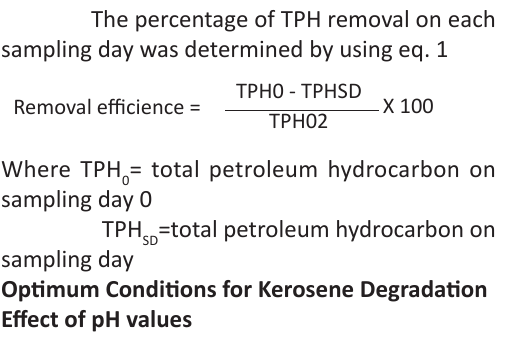
Fig. 1. Screening of isolates bacteria sp. for kerosene degradation.